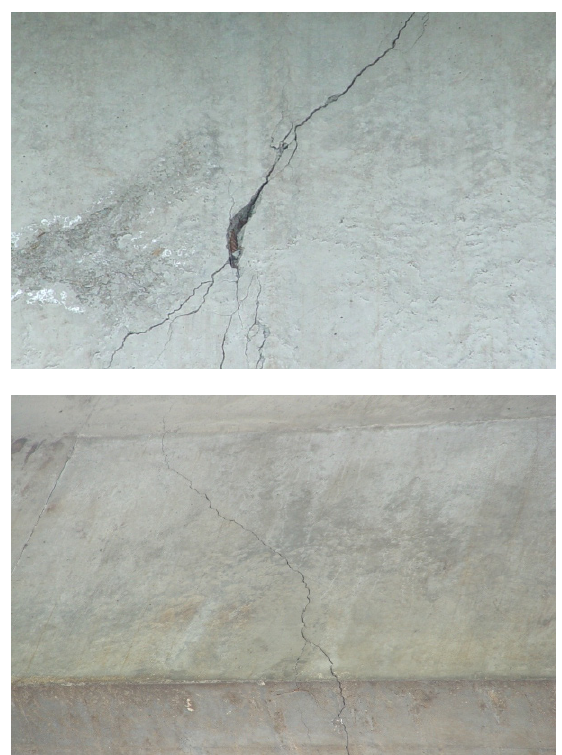
Figure 3. The cracks in the box girders of Hashuang